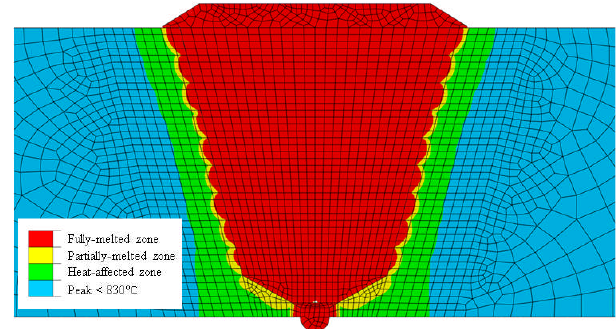
Figure 15. Peak temperature contours.